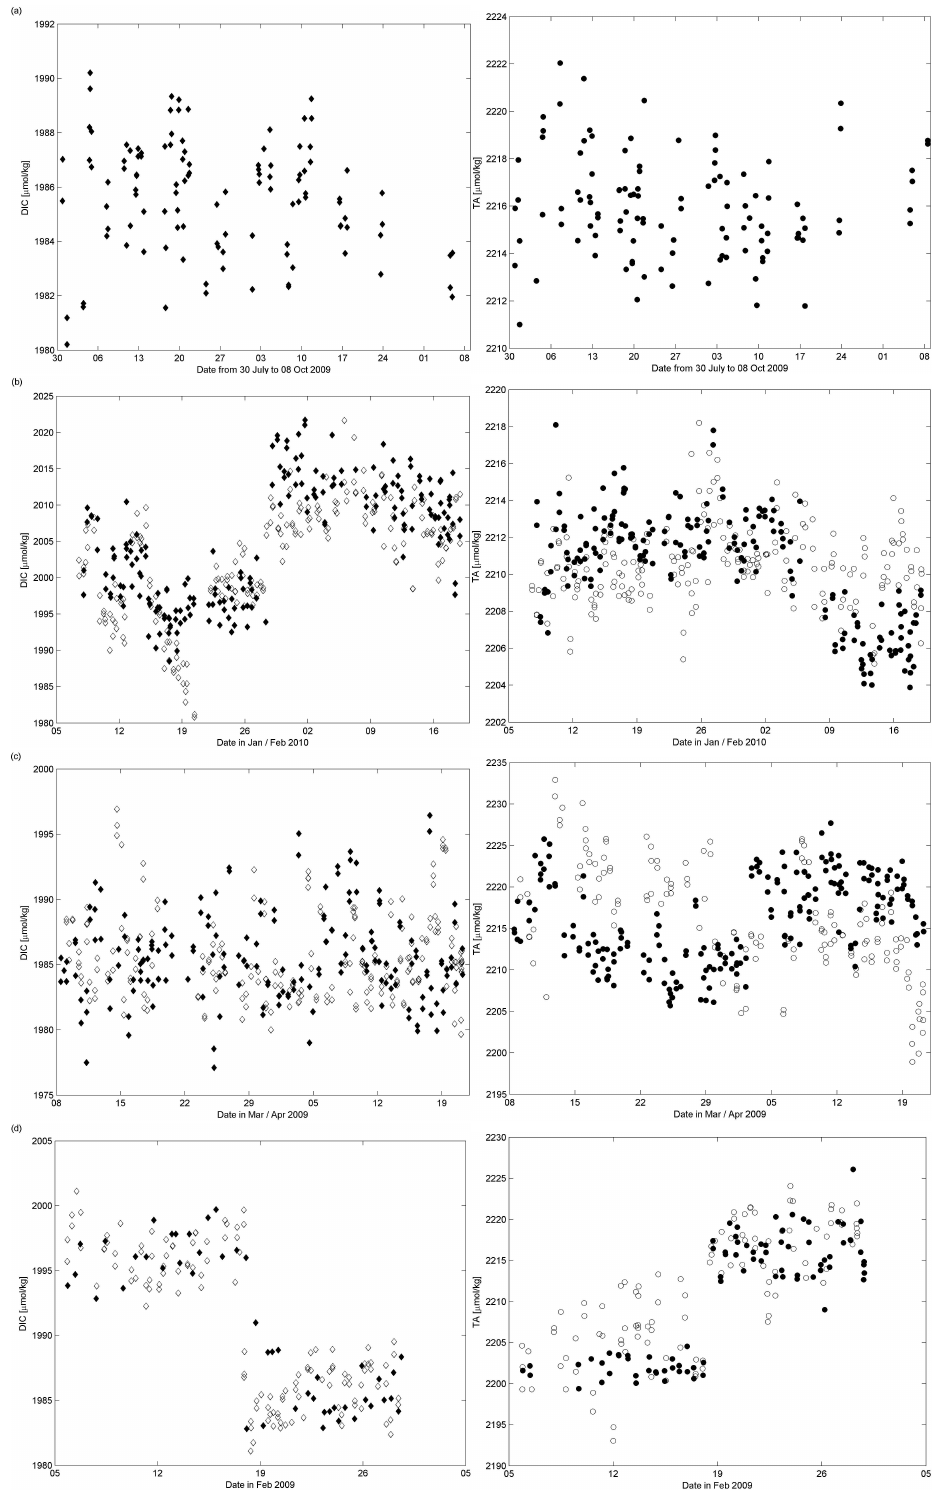
Figure 2. DIC and TA values of CRM analyses over time for (a) DI332, (b) DI346, (c) JC032, and (d) JC031. Solid symbols are DIC and TA values analysed on VINDTA #007, whilst open symbols are from VINDTA #004 during DI346 and from the stand-alone extractor during JC031 and JC032; only one instrument was used for samples from DI332. Please note that these values are plotted after outliers were identified and removed (see text in Sect. 4.1), but prior to re-calibration; o ff sets in these plots indicate for example a change in CRM (e.g. JC031) or a change in sample pipette volume (DI346), and di ff erent acid batches for